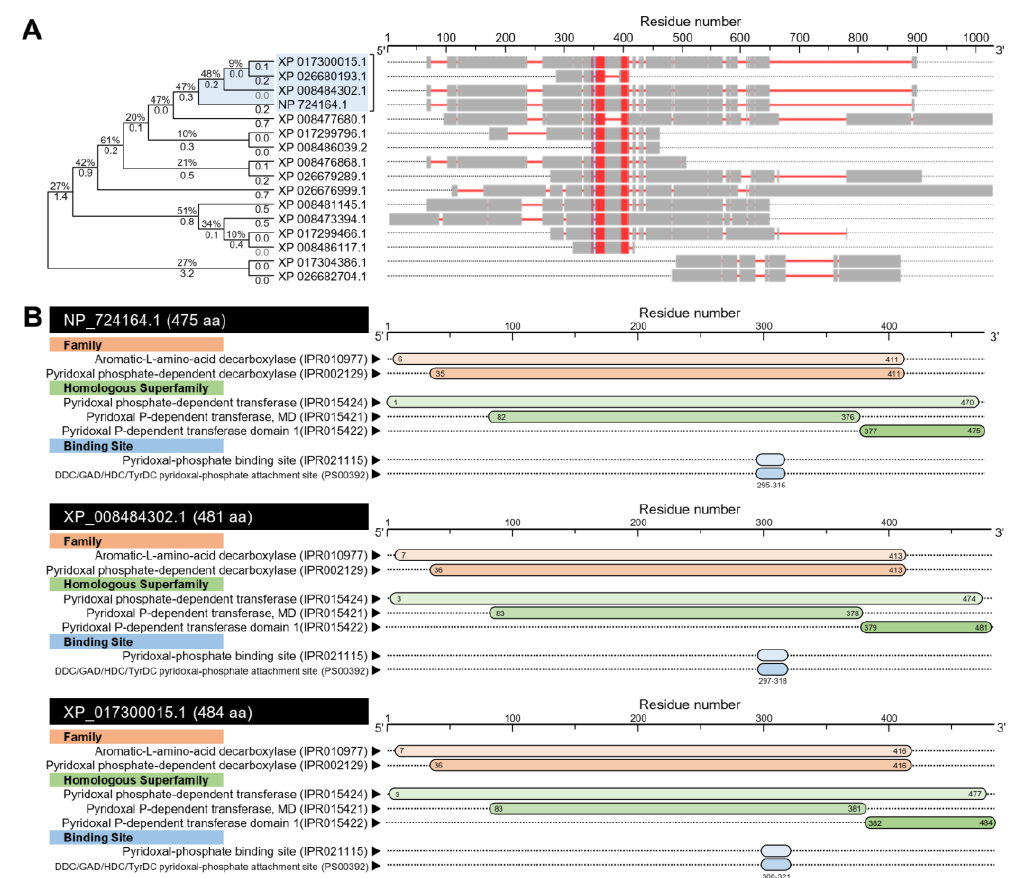
Figure 4. In silico analysis of aromatic L-amino acid decarboxylase ( DcAADC ) of Diaphorina citri . ( A ) Evolutionary analysis using maximum likelihood method and its associated multiple protein sequences alignments using Constraint- Based Alignment tool (COBALT) analysis. The AA sequences were identified using the Protein–Protein BLAST (BLASTp) using dopa decarboxylase, isoform B (GenBank Accession no. NP_724164.1) from Drosophila melanogaster , as a query sequence, against Diaphorina citri genome available in GenBank, the national center for biotechnology information website (NCBI, http://www.ncbi.nlm.nih.gov/gene/, 12 February 2021). The tree with the highest log likelihood (−11911.42) is shown. The tree is drawn to scale, with branch lengths measured in the number of substitutions per site (next to the branches). The proportion of sites where at least one unambiguous base is present in at least one sequence for each descendent clade is shown next to each internal node in the tree. Evolutionary analyses and the joint tree were conducted in MEGA-X software. In the COBALT analysis, residues were colored using a column-based method according to their relative entropy threshold. Aligned columns with no gaps are colored blue and red, where the red color indicates highly conserved columns and blue indicates less conserved ones. ( B ) The protein functional and conserved domains analysis of DmAADC (NP_724164.1), DcAADC -1(XP_008484302.1), and DcAADC -2 (XP_017300015.1) using InterPro Scan tool (https://www.ebi.ac.uk/interpro/, 12 February 2021). Pyridoxal P-dependent transferase, MD: Pyridoxal phosphate-dependent transferase, major